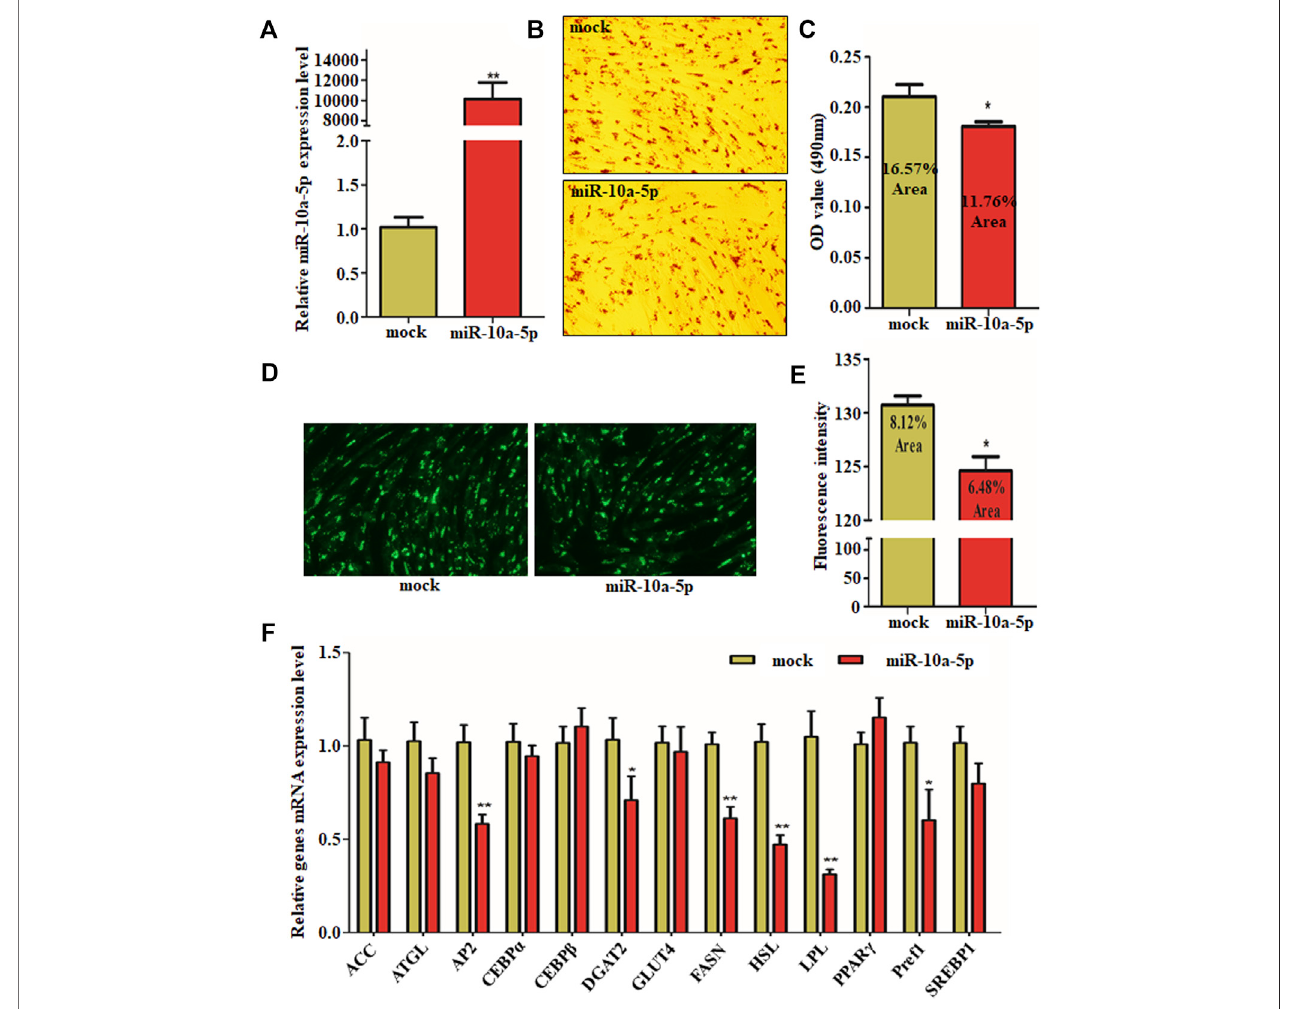
FIGURE 2 | Overexpression of miR-10a-5p inhibits GIPC differentiation. (A) qRT-PCR analysis oflevels of miR-10a-5p expression in GIPCs with mimics or control transfected for 24 h. (B) Representative images of Oil Red O staining of GIPCs with miR-10a-5p mimics or control and (C) semi-quantitative assessment of Oil Red O content absorbance detection at 490 nm. (D) Representative images of mature adipocytes stained with BODIPY and (E) stained area was measured using ImageJ. (F) qRT-PCR analysis of levels of genes expression in GIPCs with miR-10a-5p mimics or control. N > or (cid:1) 3, * indicates p values < 0.05 and ≥ 0.01, ** indicates p values <